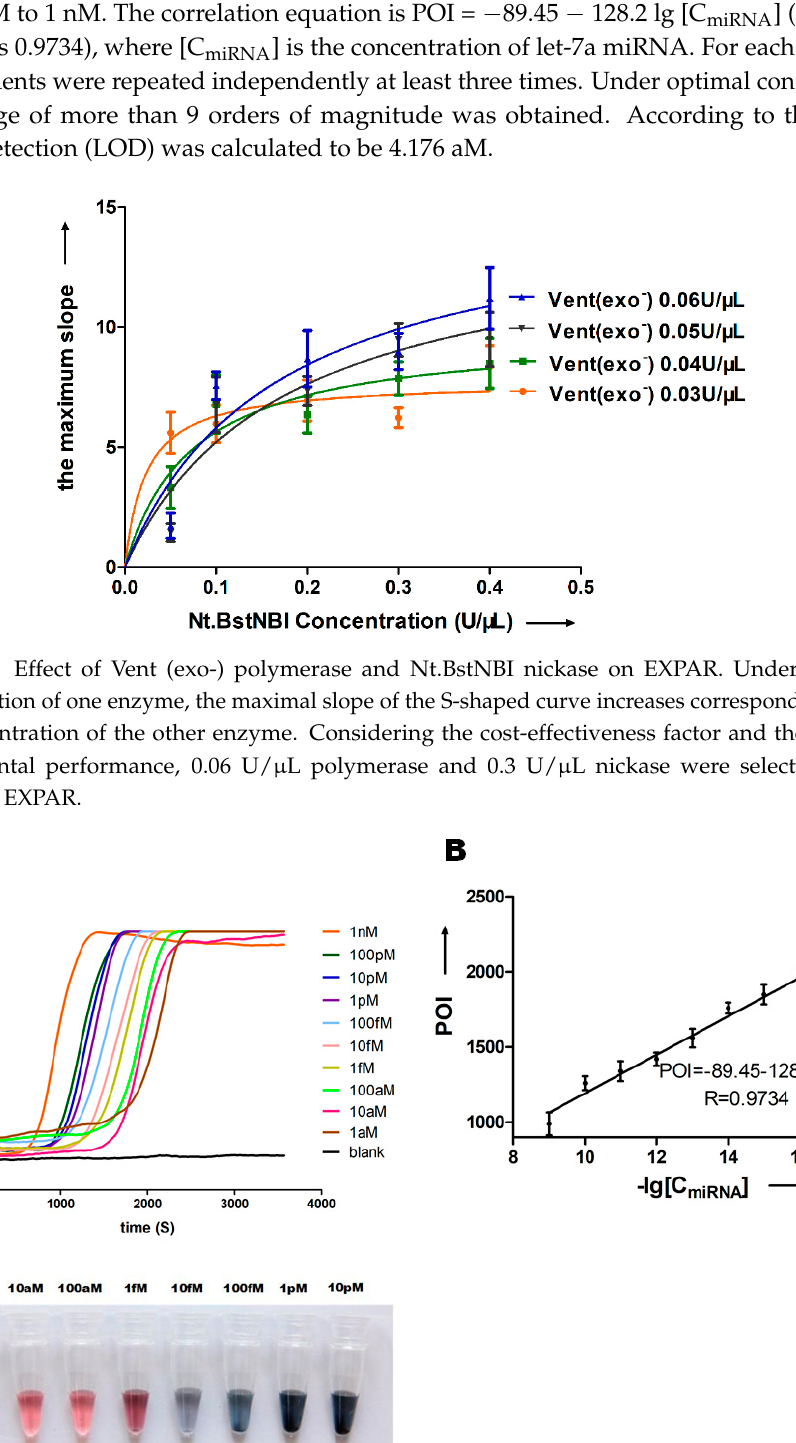
Figure 5. The sensitivity of EXPAR-AuNP visual detection. ( A ) Real-time EXPAR fluorescence signals of let-7a miRNA at different concentrations; ( B ) calibration line of let-7a concentrations versus the POI values; ( C ) EXPAR-AuNPs visual detection of let-7a miRNA at different concentrations.